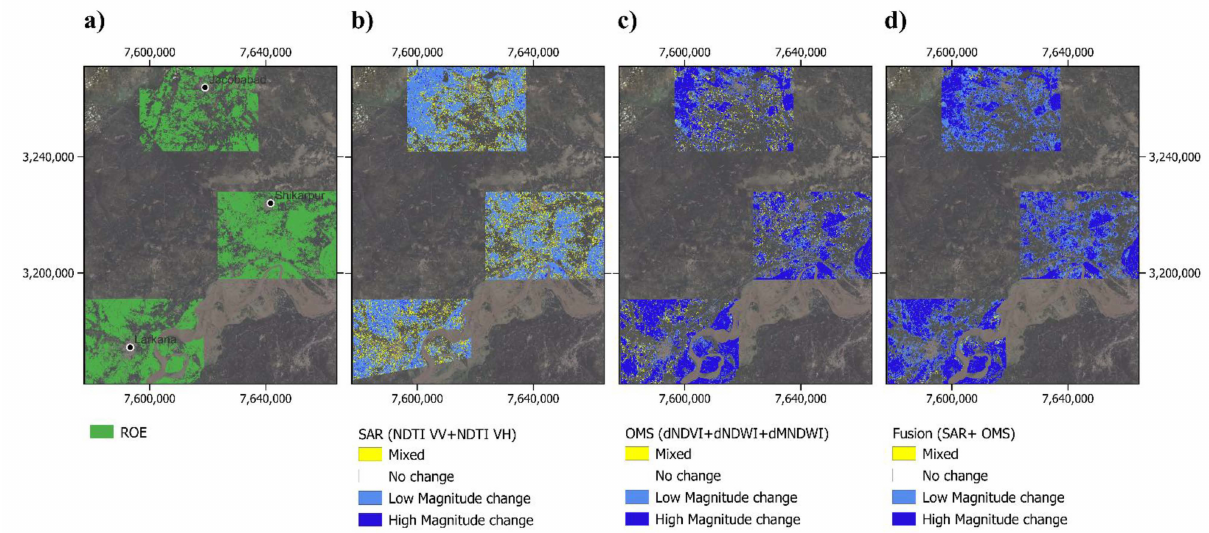
Figure 10. Flood-related change maps for the Sindh Province case study, obtained from the ( b ) OMS, ( c ) SAR, and ( d ) fusion datasets, in comparison to ( a ) the Reference Observed Event (ROE) [41] (coordinate reference system: WGS84/World Mercator).